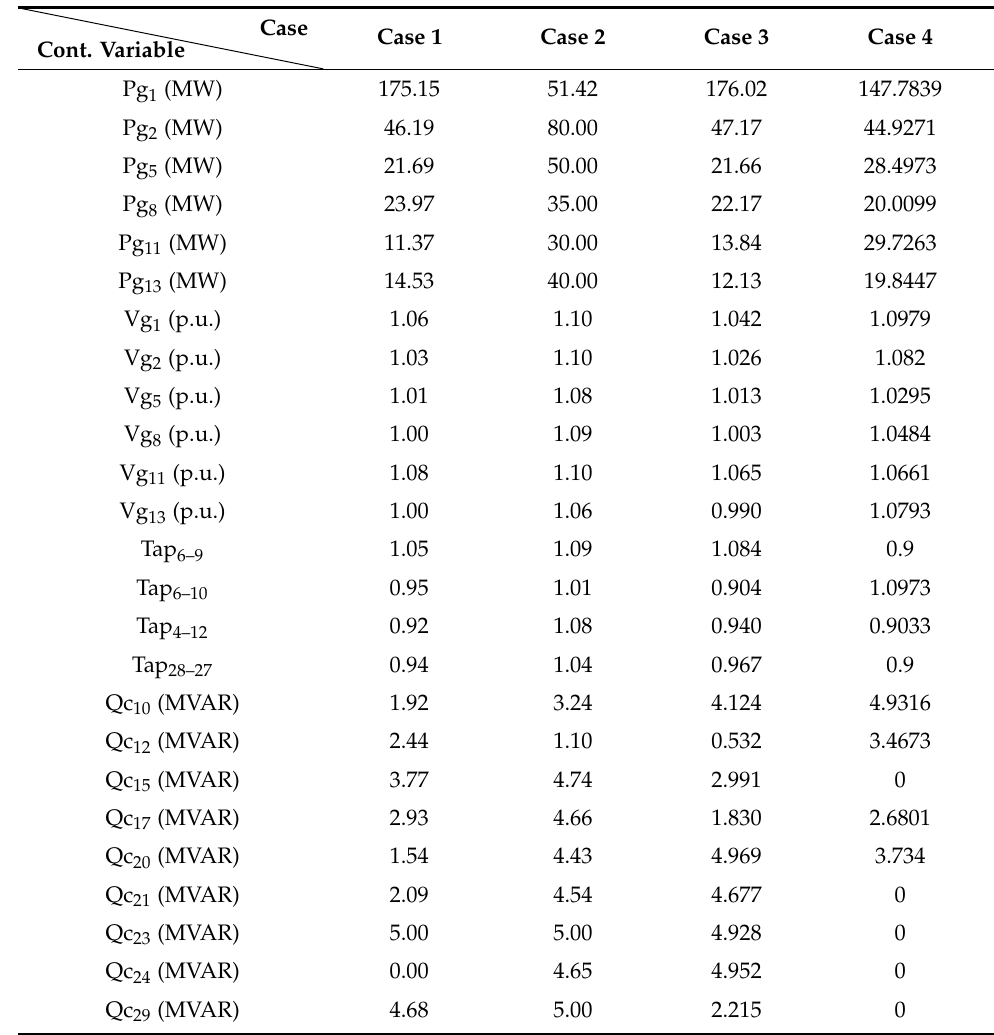
Table 4. Simulation results for a SOF-based OPF.